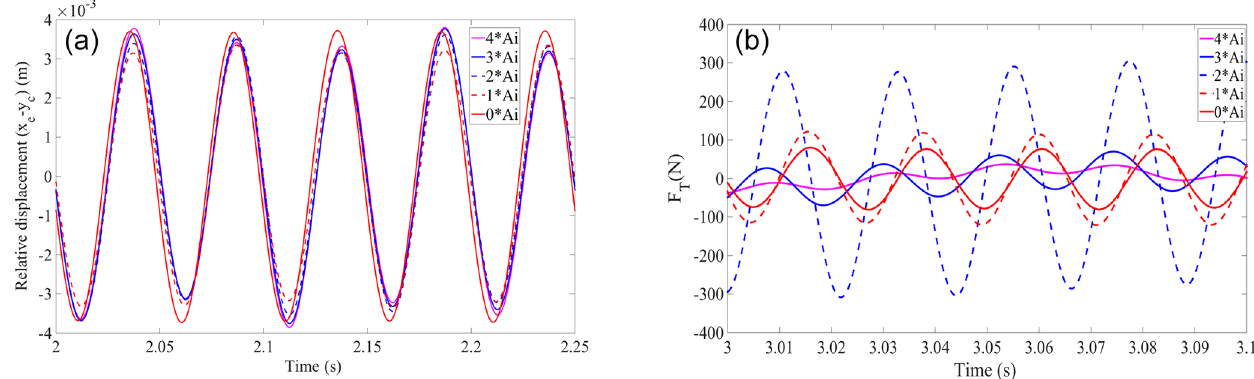
Figure 15. Effect of different excitation sources on the mount: (a) relative displacement of the engine and the frame and (b) transfer force.